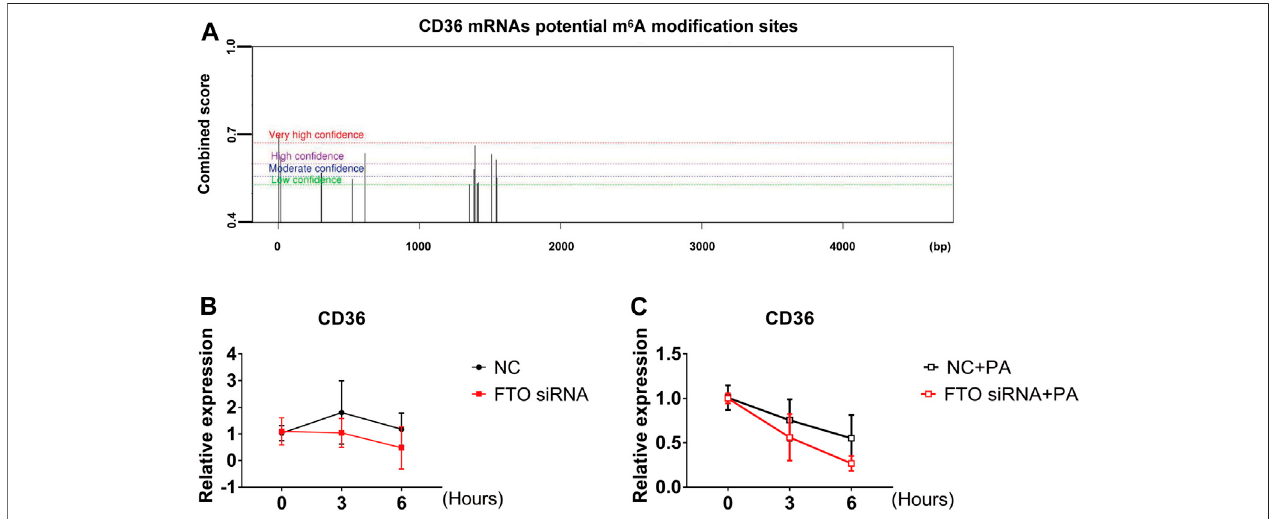
FIGURE 6 | FTO regulates CD36 expression through the m 6 A modi fi cation. (A) The prediction of potential m 6 A modi fi cation sites on CD36 mRNA. (B) Stability of CD36mRNAinAC16cellsafterFTOsiRNA transfectionfor24 h. (C) qRT-PCRanalysisofCD36mRNAstabilityafterFTOsilencinginPA-treatedstimulationcells, n (cid:1) 3.